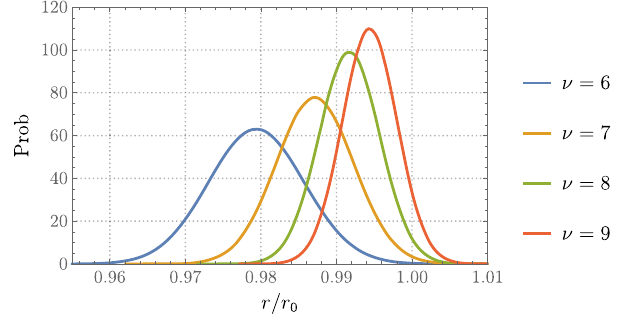
FIG. 4. Probability distribution, from the variational wave function, for the radius in the fuzzy sphere phase for N ¼ 8 and different ν . The horizontal axis is rescaled by the semi- classical value of the radius r 0 , given in Eq. (4.4) below. The width of the distribution in units of the classical radius becomes smaller as ν is